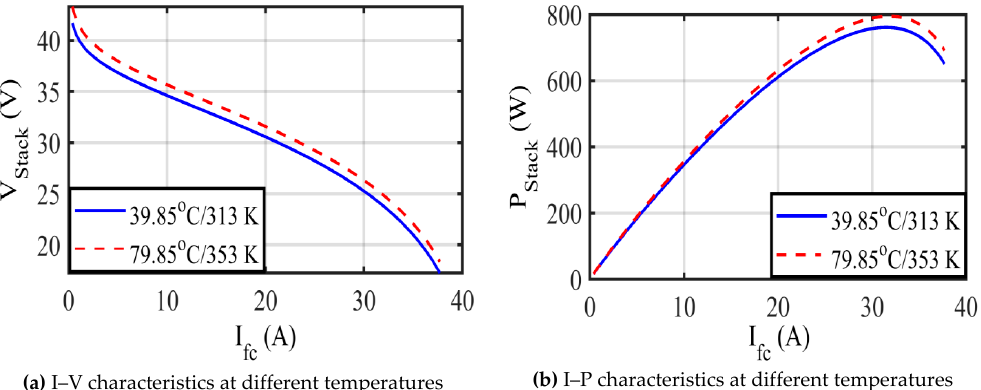
Figure 7. Characteristics of SR-12 at different temperatures.